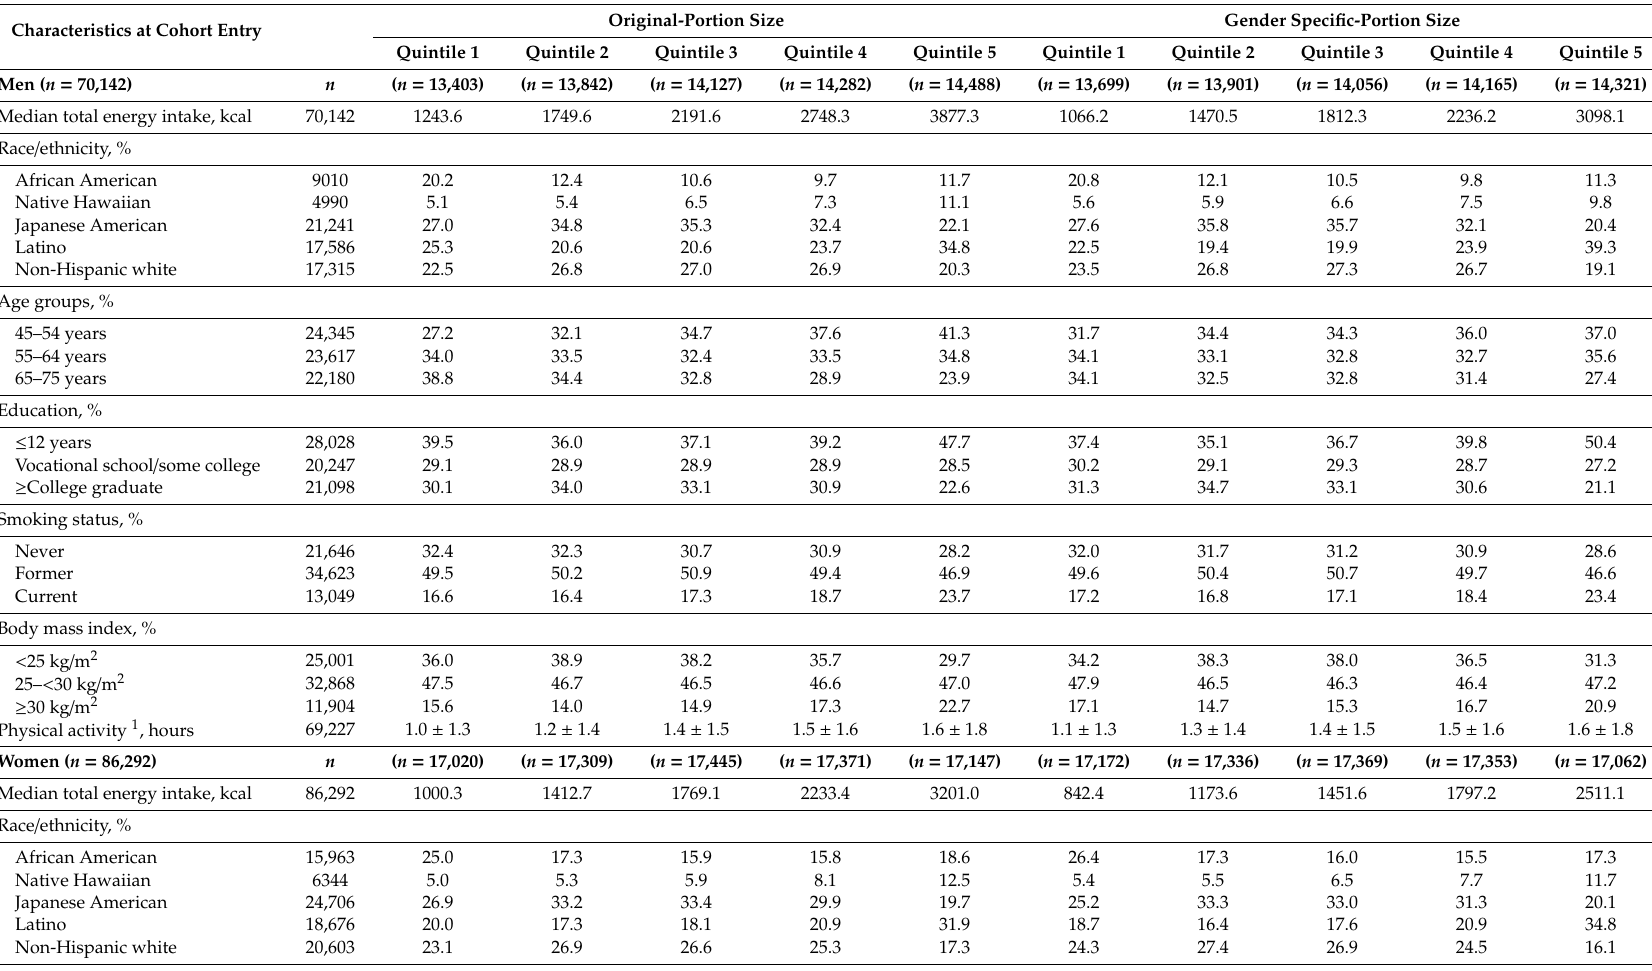
Table 1. Baseline characteristics of participants ( n = 156,434) in the Multiethnic Cohort Study by quintiles of total energy intake estimated from a food frequency questionnaire either using an original-portion size or a gender specific-portion